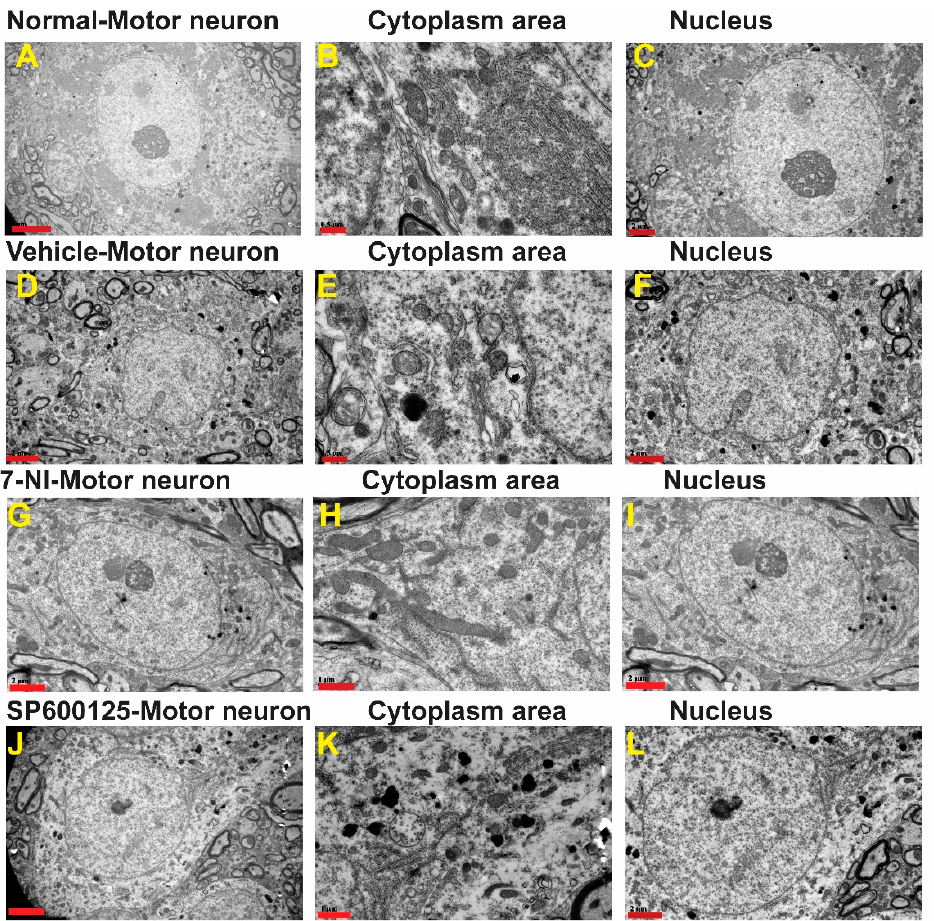
Figure 3. Ultrastructure of representative α -motor neurons. A – C : A —Ultrastructure of representative normal α -motor neuron from the contralateral side showing organelles ( B ) and nucleus ( C ). 1 μ m and 2 μ m; D – F : D —Ultrastructure of representative α -motor neuron from the ipsilateral side of a vehicle-treated rat showing organelles in cytoplasm ( E ) and nucleus ( F ). Scale bars = 0.5 μ m and 2 μ m; G – I : Ultrastructure of representative α -motor neuron from the ipsilateral side of a 7-nitroindazole-treated rat showing organelles ( H ) and nucleus ( I ). Scale bar = 1 μ m and 2 μ m; J – L : J —Ultrastructure of representative α -motor neuron from the ipsilateral side of as SP300125-treated rat showing organelles ( K ) and nucleus ( L ). Scale bar = 1 μ m and 2 μ m.